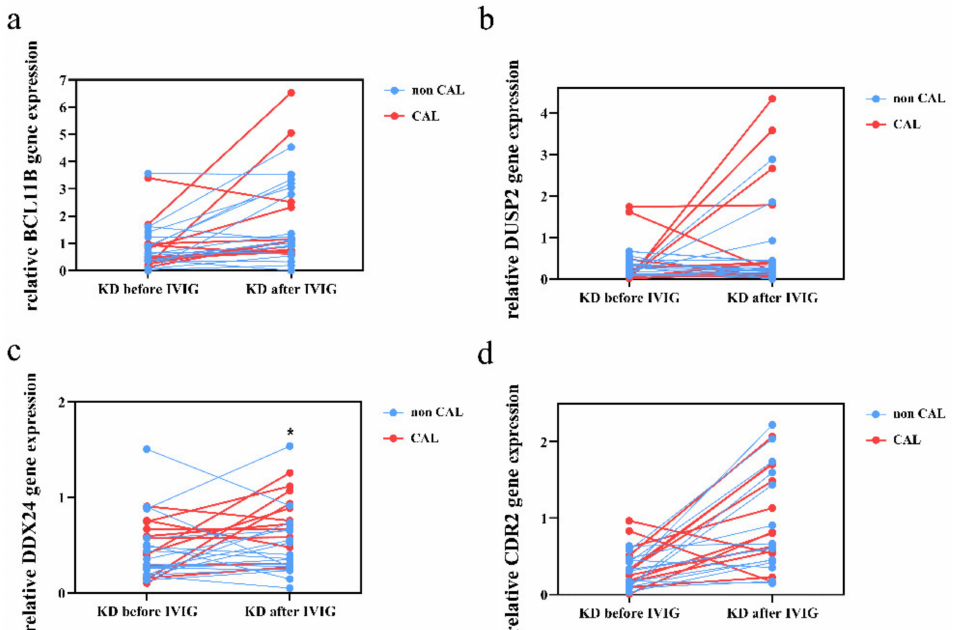
Figure 4. Comparison of BCL11B ( a ), DUSP2 ( b ), DDX24 ( c ), and CDR2 ( d ) expression determined by quantitative real-time reverse transcription polymerase chain reaction between Kawasaki disease patients with or without coronary arterial lesion (CAL). * Indicates significance ( p < 0.05) Data are expressed as mean ± standard error for the three